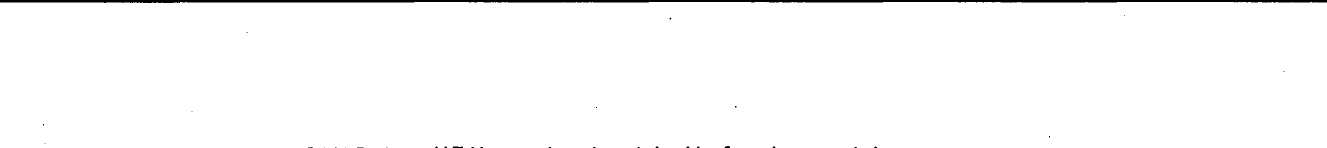
Figure I. A typical representation of a learning